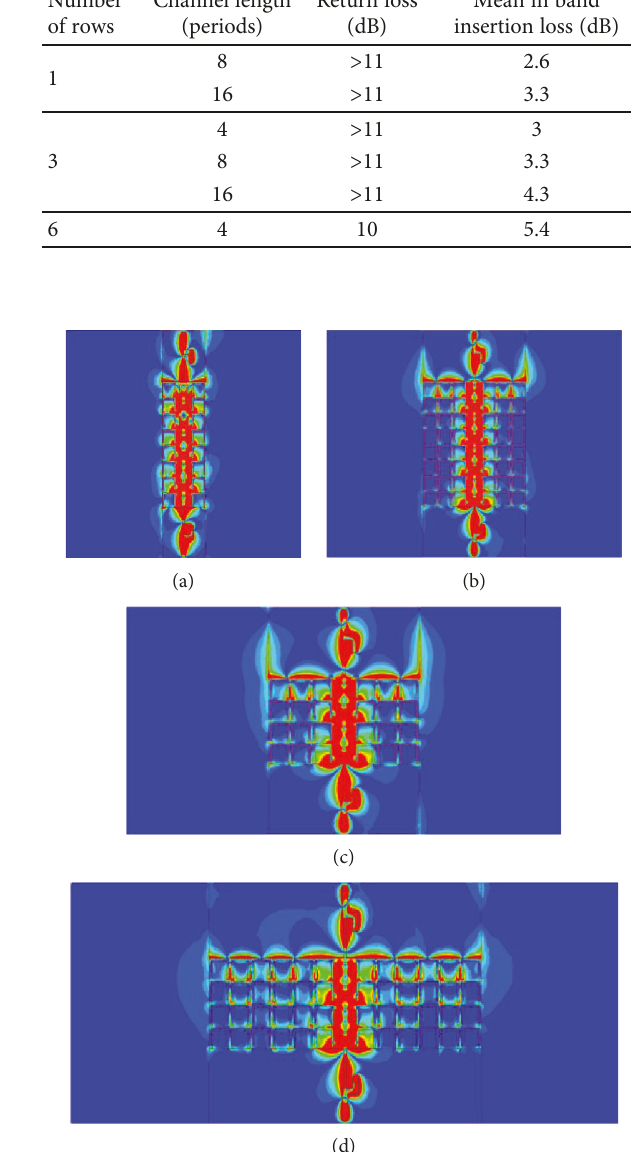
Figure 15: Electric fi eld distribution at f =10.5GHz in the EBG waveguide. (a) Channel length of 8 periods with 1 row and (b) with 3 rows. (c) Channel length of 4 periods with 3 rows and (d) and 6